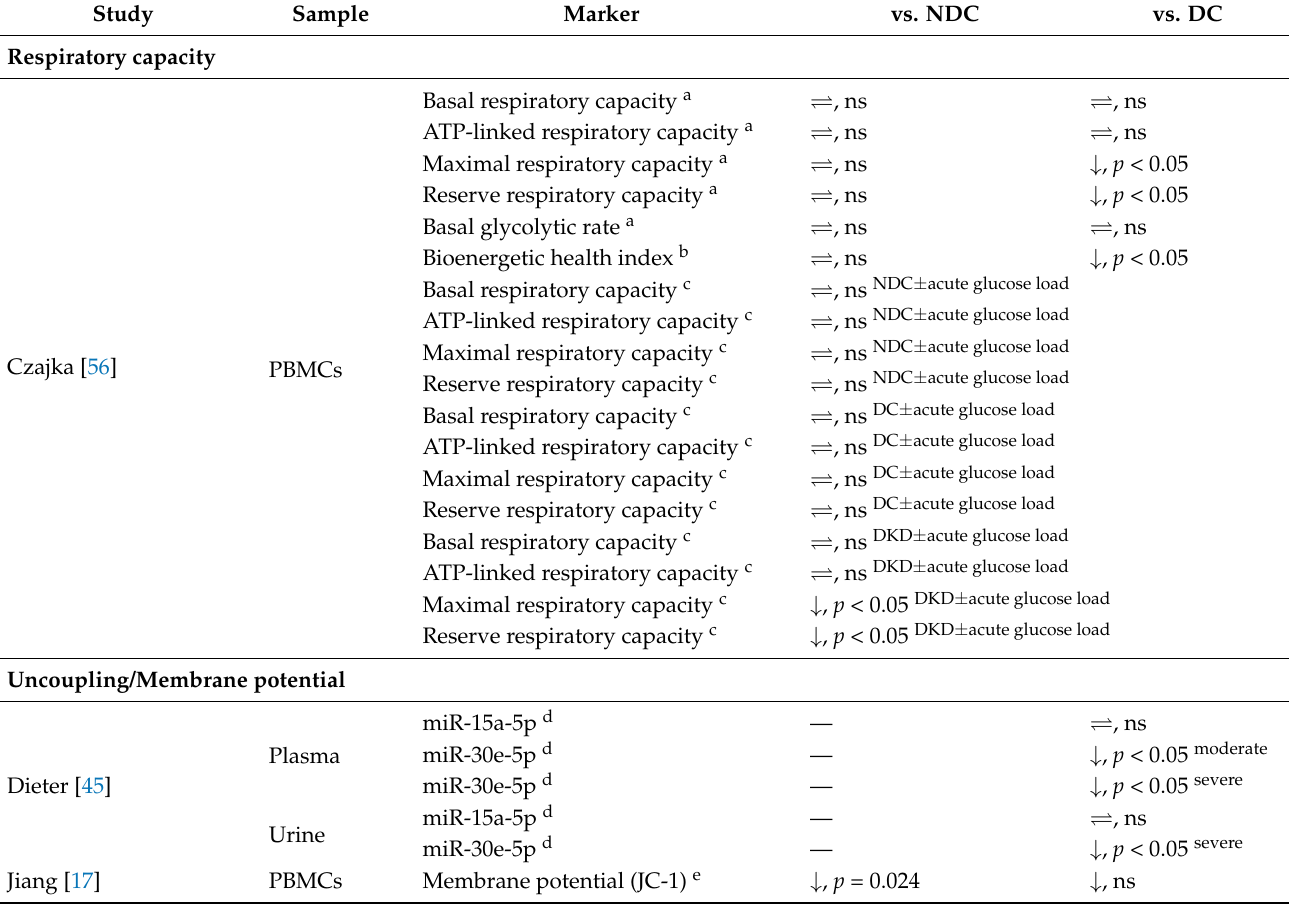
Table 5. Summary of mitochondrial respiratory capacity and membrane potential in individuals with DKD compared to NDC and/or